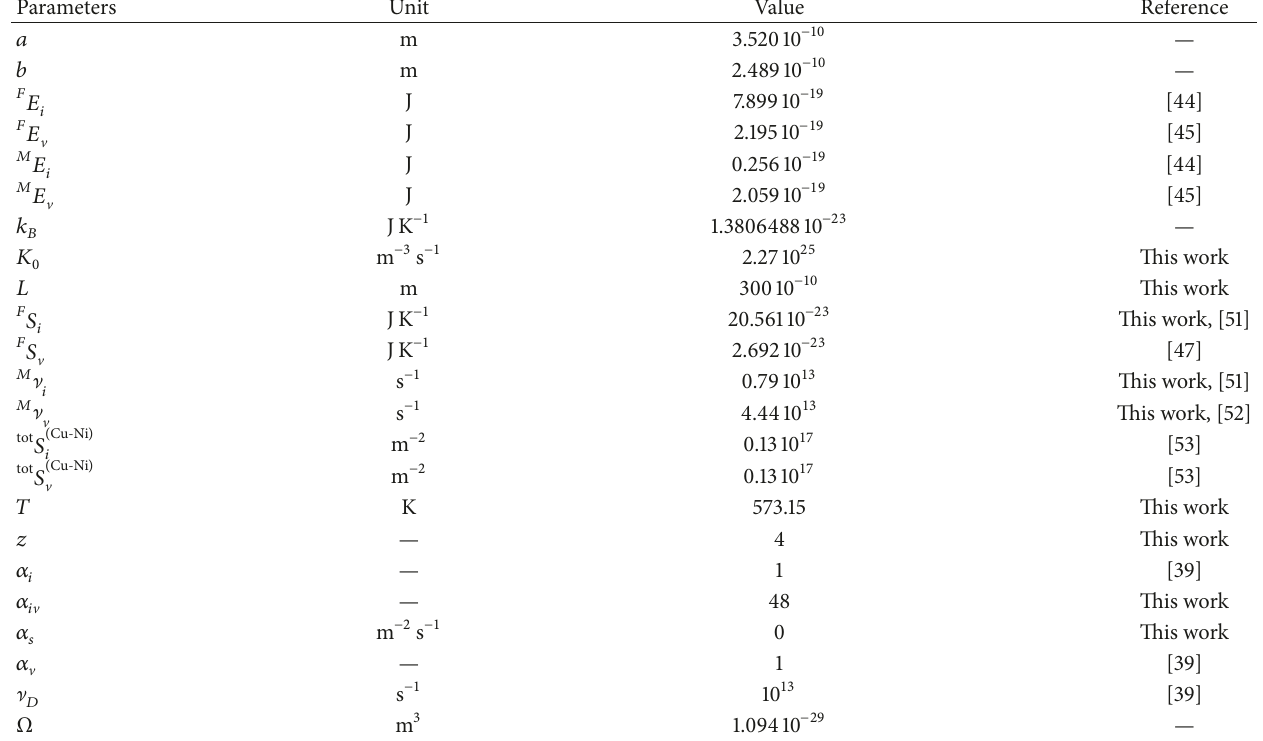
Table 4: Model parameters for nickel.